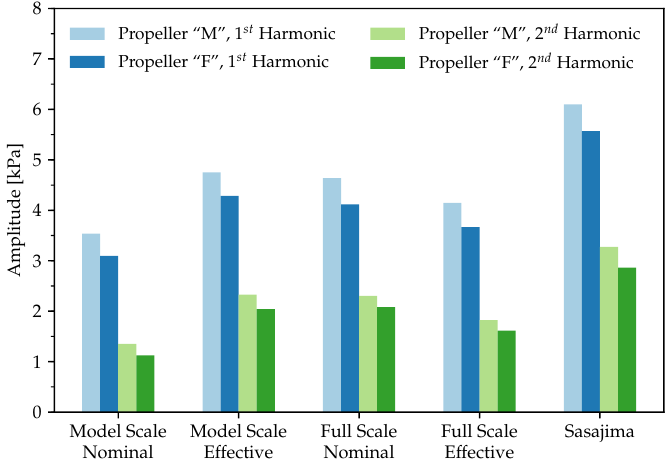
Figure 6. Pressure pulse